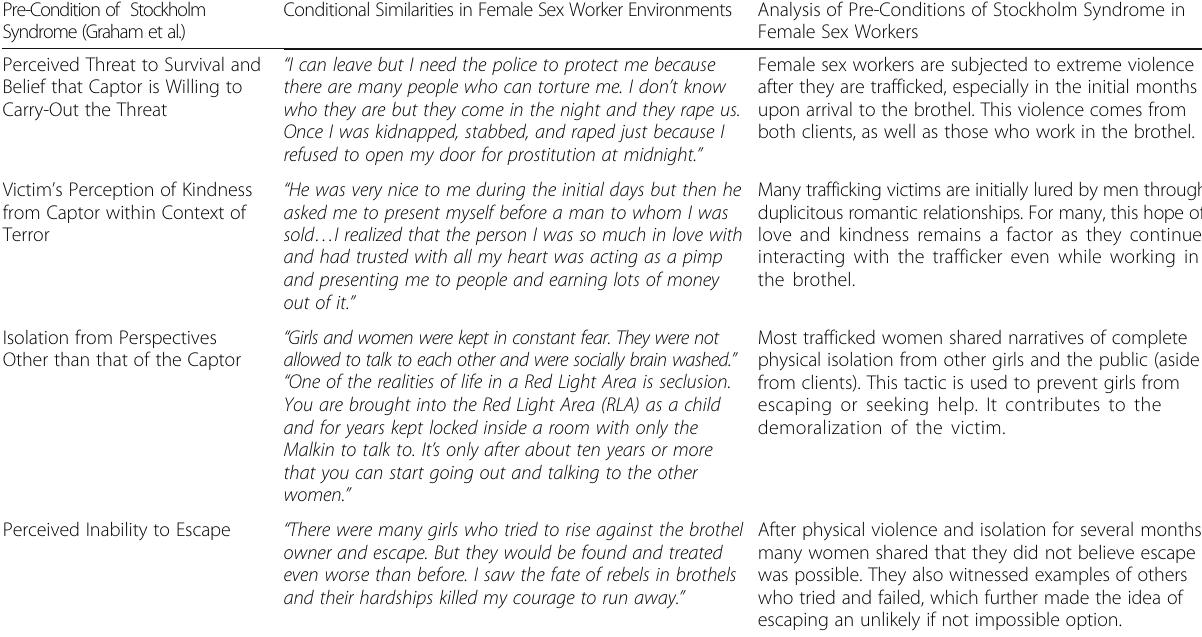
Female Sex Workers